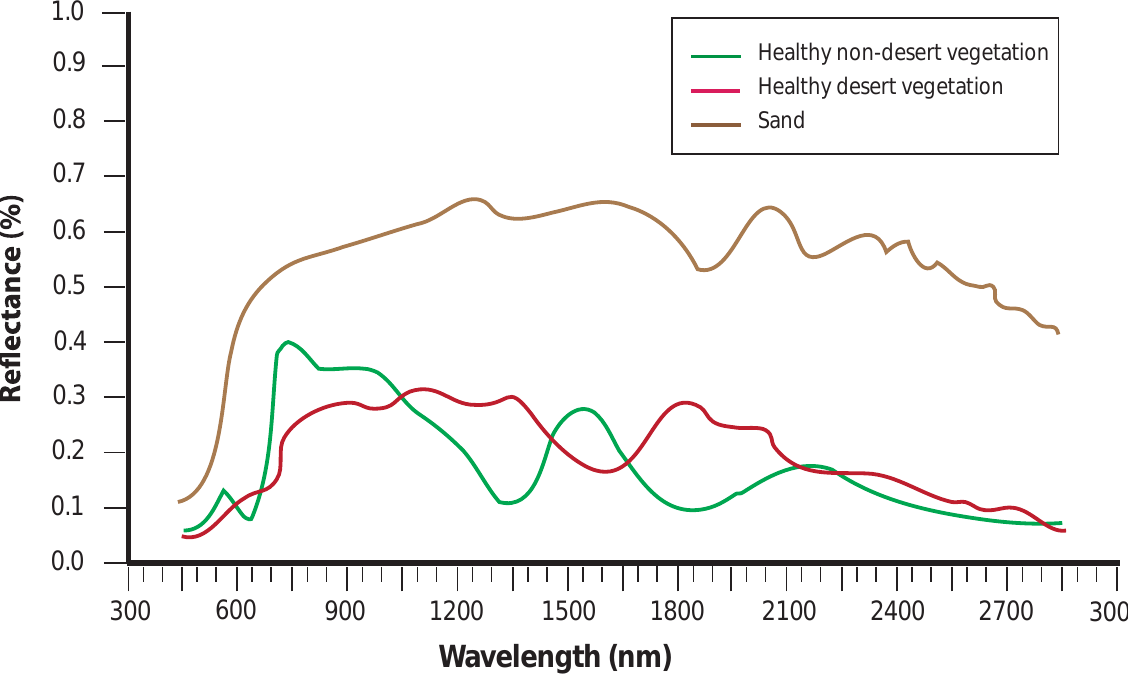
Figure 1. Spectral response curves after Ehleringer (1981) [18] for healthy non-desert and desert vegetation, and sand. Notice how the spectral reflectances for desert vegetation are spectrally dissimilar and do not exhibit a strong red edge (an abrupt change in the 680 nm (red) to 800 nm (near infrared) wavelength region) due to reduced leaf absorption in the visible region of the electromagnetic spectrum and strong wax absorption around the 1,720 nm wavelength region